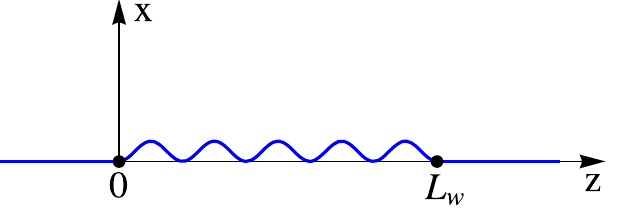
FIG. 8. Wiggler of length L w ¼ N w λ w with the orbit shown by blue line.